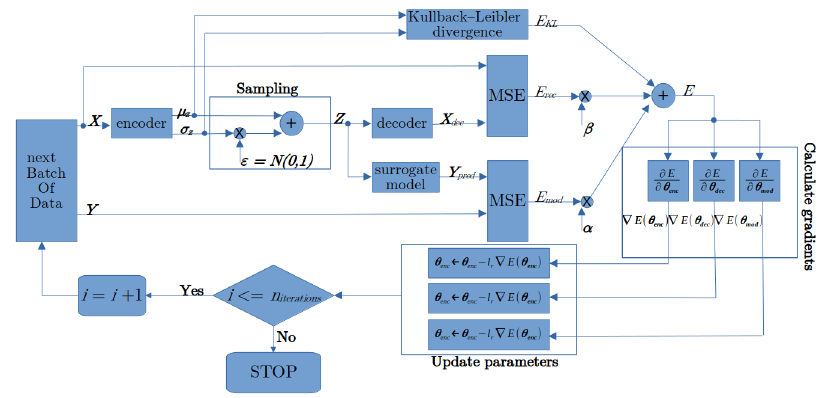
Figure 2. Flux diagram of the custom training